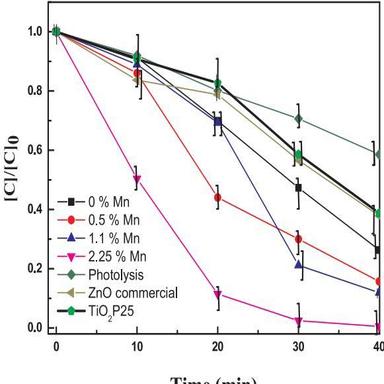
Photocatalytic degradation of anthracene (20 ppm) in ethanol:water (1:1) with commercial ZnO, ZnO and n-ZnO/p-MnO (Mn = 0.5%, 1.1% and 2.25%) composites at 40 min of UV illumination (irradiation at 365 nm, I0 = 3.30 mW cm−2 ). The direct photolysis (in the absence of semiconductor particles) is also included.